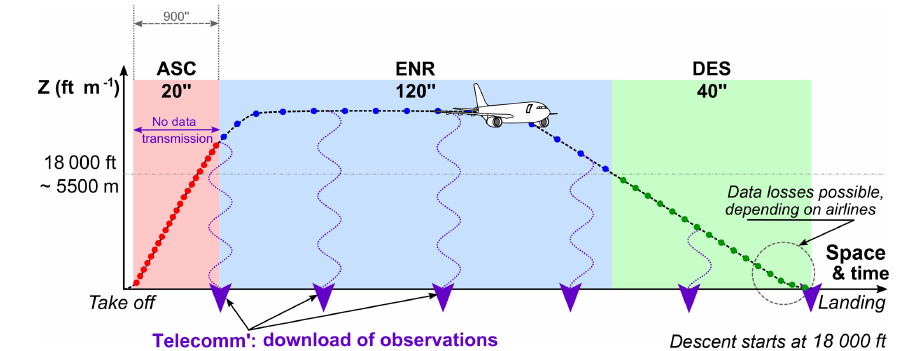
Figure 1. Schematic diagram with the three flight phases: ASC (ascent, in red), ENR (en-route, in blue) and DES (descent, in green). The sampling period is shown below the name of the phase. The DES phase starts when the plane flies below the 18000ft limit. Thus, these data sample a thinner atmospheric layer than ASC. The first communication to download observations to the ground is done after the ascent phase. For most companies, the last DES data packet is transmitted during taxi on runways after landing. But for some companies, the last data packet at the end of the descent is not transmitted if the aircraft lands before this last data packet is transmitted to the ground. In such a case, a substantial loss of data is